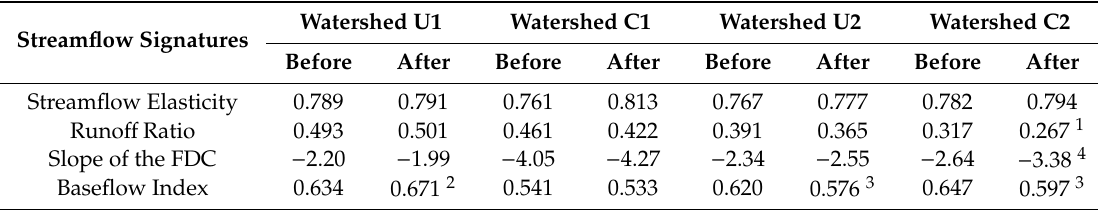
Table 5. Mean streamflow signature values for the before- and after-urbanization periods by watershed. Footnotes indicate the p value of trend analysis over the study